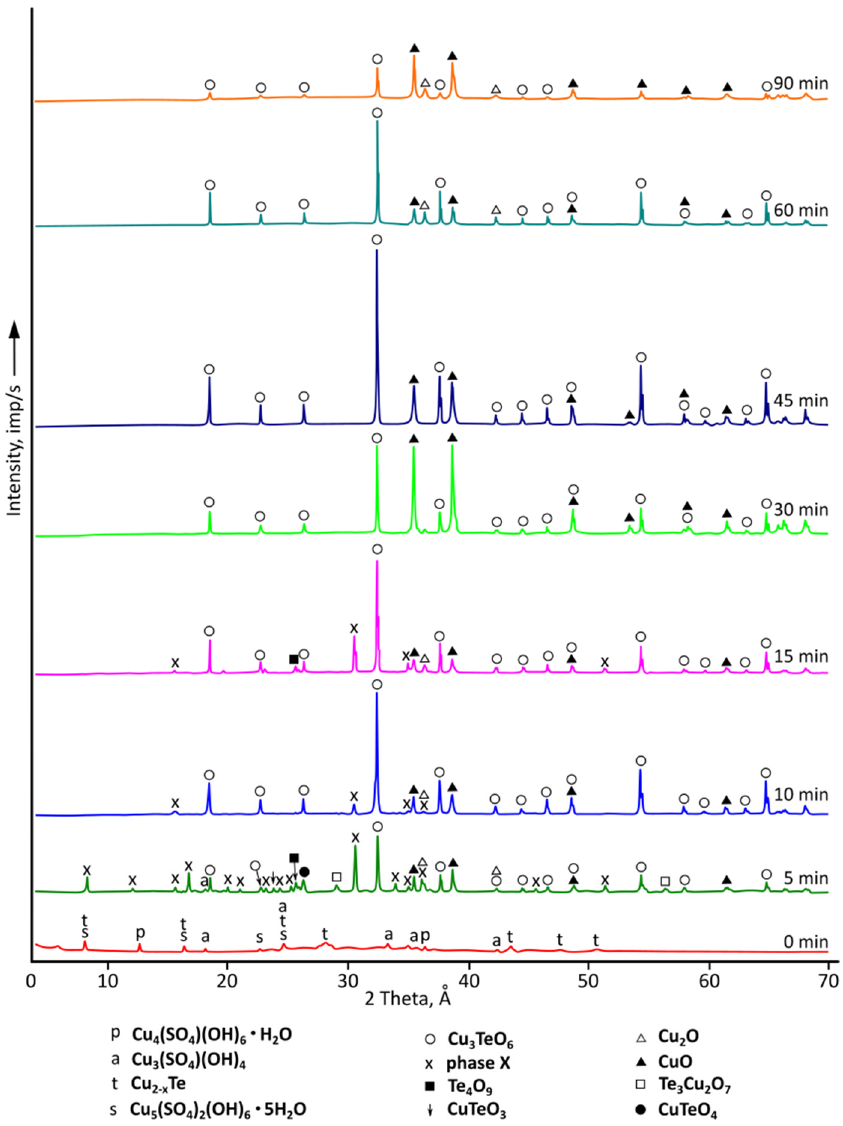
Figure 6. X-ray patterns of residues were obtained at 900 °C, 0.67 kPa, and different roasting durations.